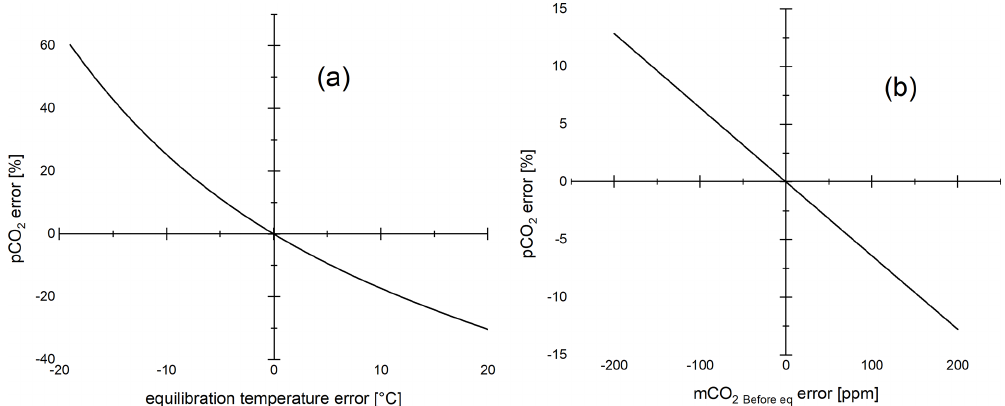
Figure A1. Error for a hypothetical sample with CO 2Beforeeq = 400ppm, CO 2aftereq = 1000ppm, equilibration temperature of 20 ◦ C, and HR = 1 (a) depending on error in equilibration temperature and (b) depending on error in initial headspace gas composition.